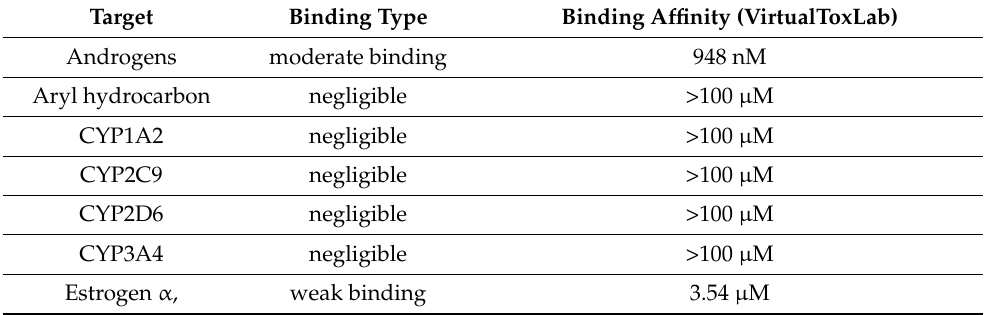
Table 2. Binding of quercetin to various